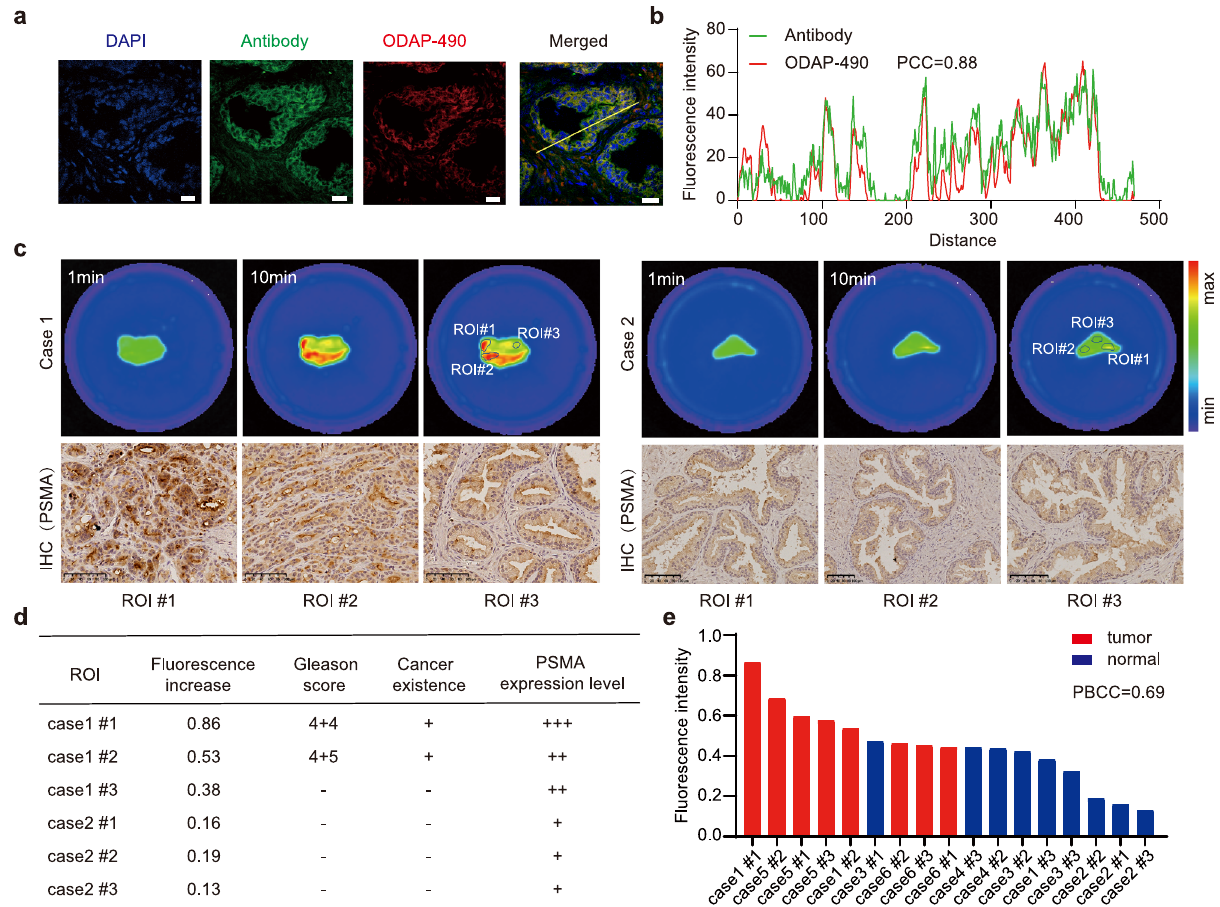
Fig. 4 Wash-free imaging of PCa surgical specimens. a Fluorescence image of surgical specimens co-stained by PSMA antibody and ODAP-490. Nucleus were stained with DAPI and shown in blue. Antibody and ODAP-490 staining were shown in green and red, respectively. Scale bar, 10 μ m. Experiment was repeated three times independently with similar results. b Correlation between antibody and ODAP-490 stains. Fluorescence intensities corresponding to cross-section (yellow lines) in panel a . c Fluorescence image of surgical specimens incubating with ODAP-490. Representative images of corresponding PSMA immunohistochemistry (IHC) of in different regions of interest (ROIs) are shown below. Scale bar: 100 μ m. IHC results were repeated three times independently with similar results. d Correlation of the fl uorescence intensity, Gleason score, cancer existence, and PSMA expression level of each ROIs in panel c . e Summary of fl uorescence increase at ROIs in six clinical specimens incubated with ODAP-490. PBCC point-biserial correlation coef fi cient. Source data are provided in Source Data fi added to the mixture drop by drop with continuous stirring. The reaction mixture was stirred on ice bath for another 2h. After the reaction completed, the mixture